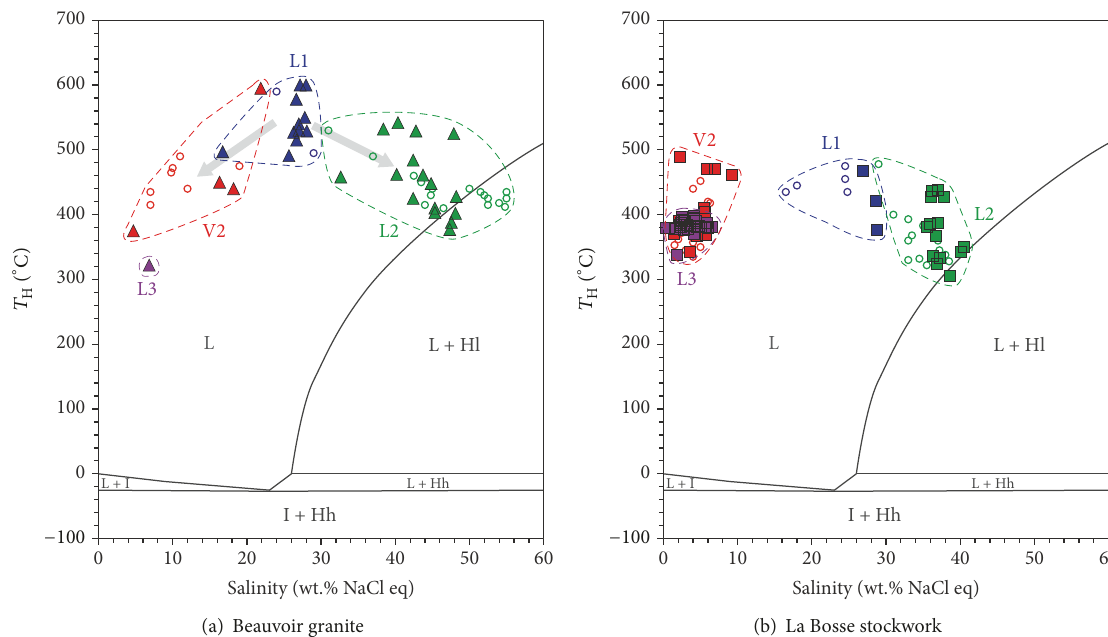
Figure 9: Salinity versus 𝑇 H diagram for the different generations of fluid inclusions from the Beauvoir granite (a) and the La Bosse stockwork (b) studied in this work (filled symbols) and compiled with the previous data (open circles) from A¨ıssa et al. [46]. Data are given in Table 1. Phase equilibrium curves for the pure H 2 O-NaCl system [43] are reported. L = liquid; Hl = halite; Hh = hydrohalite; I = ice.